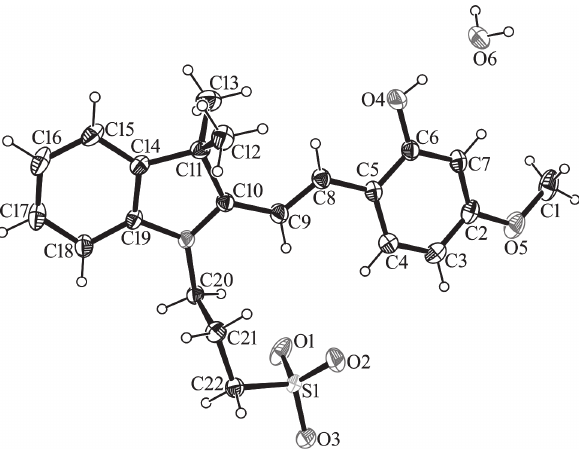
Table 2: Fractional atomic coordinates and isotropic or